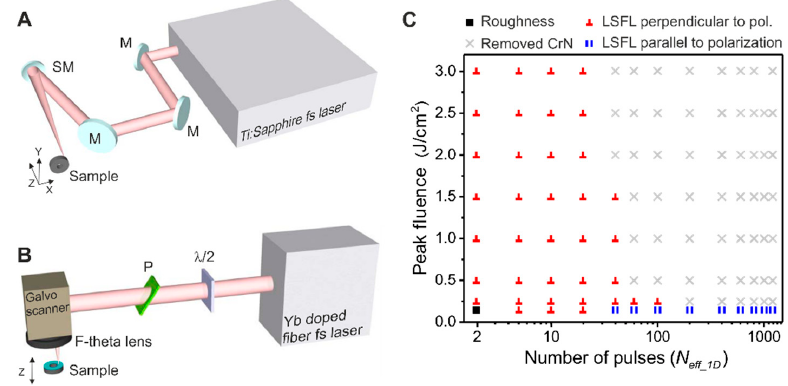
Figure 2. ( A ) Setup of the Ti:Sa laser system (BAM). The beam is directed using several mirrors (M), the polarization is defined by a half-wave plate ( 𝜆/2 ) and is finally focused in a static position on the sample by a spherical dielectric mirror (SM) of 500 mm focal length. The sample is positioned and translated by a motorized X-Y-Z translation stage. ( B ) Setup of the Yb-doped fiber laser (CSIC). The beam power is controlled by a combination of a half-wave plate ( λ/2 ) and a thin film polarizer (P). The beam scans the sample by a galvanometric mirror-based scanning head, and it is focused by a 100 mm F-theta lens. The sample is mounted in a Z -axis translation stage to control the focusing of the beam. ( C ) Plot that displays the obtained type of surface structures on CrN for a combination of number of effective pulses ( N eff_1 D ) and peak fluences used for the formation of ( ■ ) roughness, ( ∥ ) indicates the presence of LSFL , ( ⊥ ) indicates the presence of LSFL and ( × ) marks the conditions where the CrN layer has been